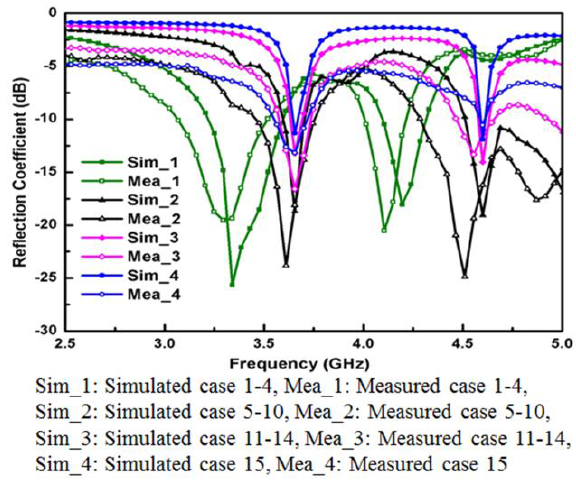
Figure 4: Return loss of the